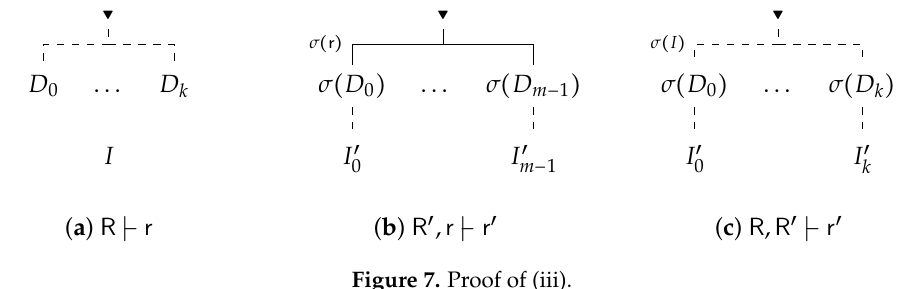
Figure 7. Proof of